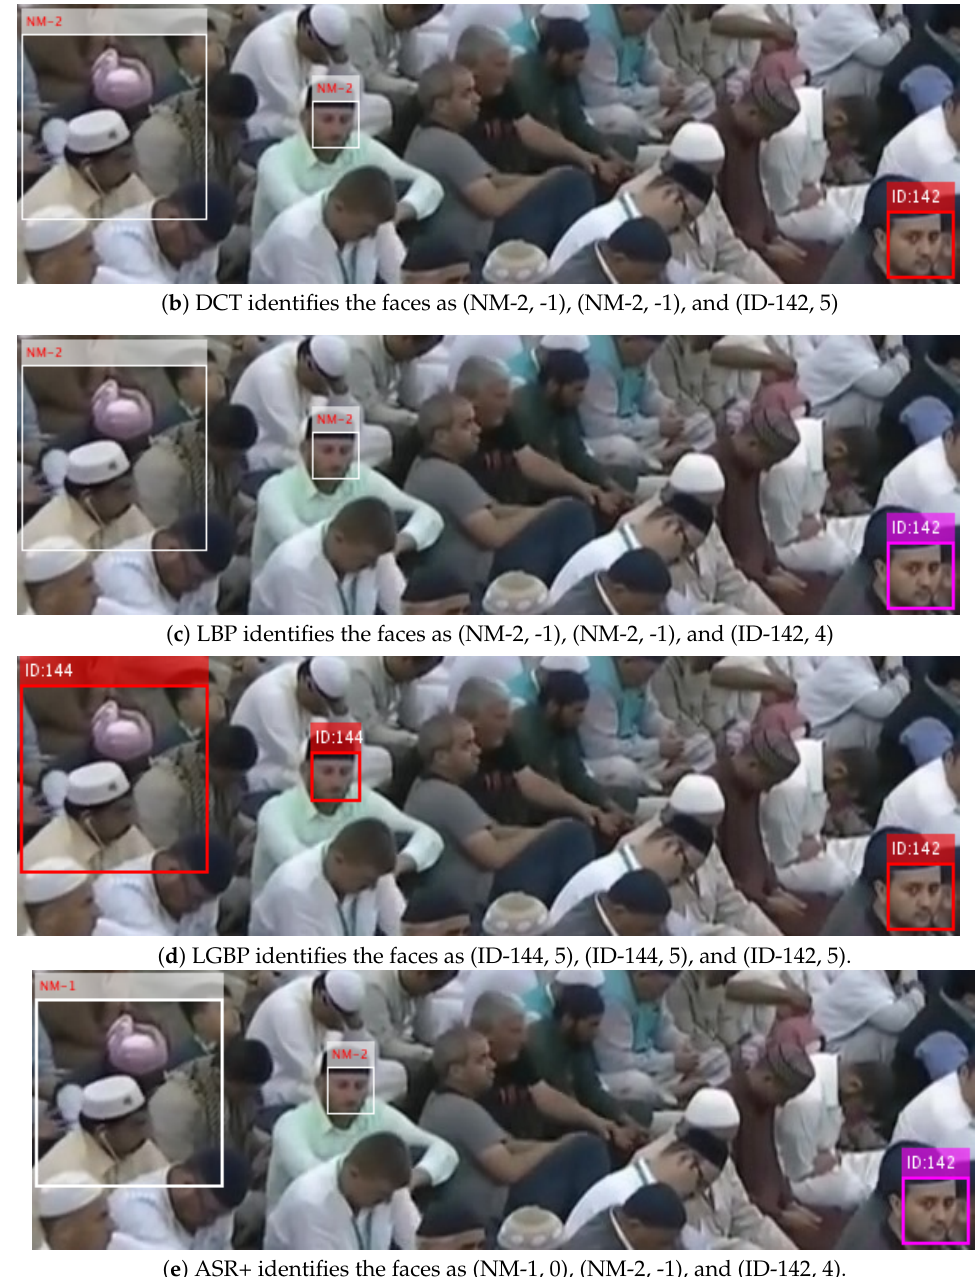
Figure 9. Personal identification by individual algorithms, where (ID, Score) pairs in every sub- caption indicate the face match and its